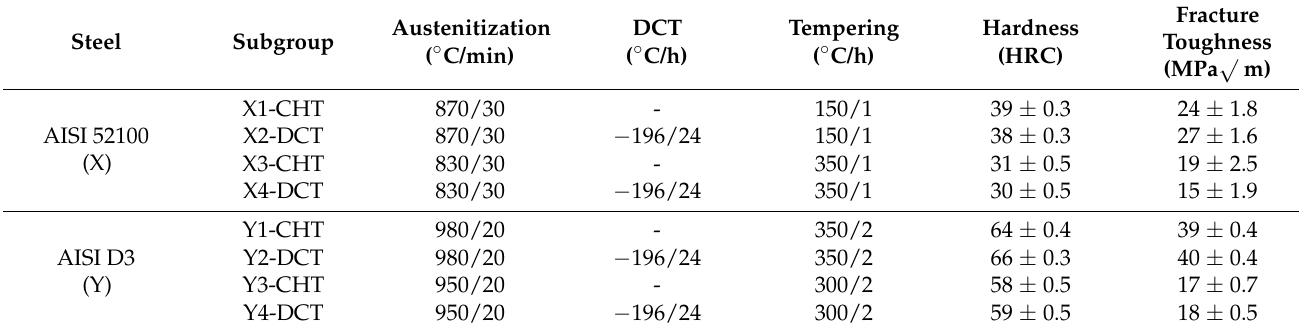
Table 2. Heat treatment of AISI 52100 (designated as X) and AISI D3 steel (designated as Y) samples with corresponding hardness and fracture toughness values, where CHT stands for conventionally heat-treated and DCT for deep cryogenic heat-treated samples. The hardness and fracture toughness were obtained by standardized procedures, explained in our previous publication